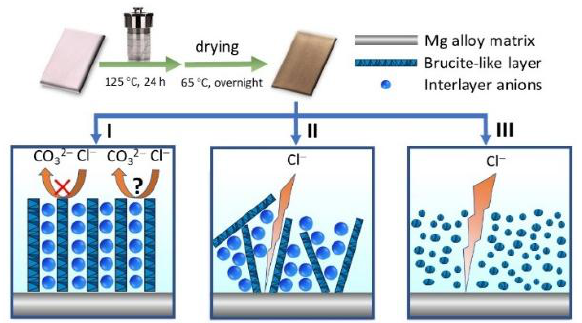
Figure 1. Schematic illustration of various microstructures of NiAl-LDH coatings prepared with different nickel salts. (I) nickel carbonate; (II) nickel nitrate; and (III) nickel sulfate. The interlayer anions are not given in case